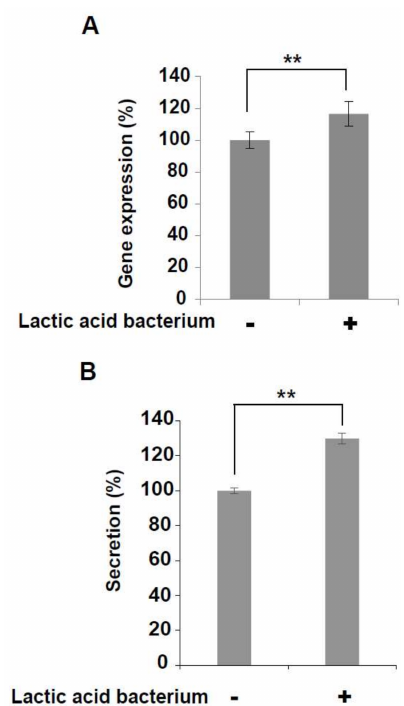
Figure 5. Increased expression and secretion levels of IFN- γ . ( A ) The expression level of IFN- γ mRNA was increased in KHYG-1 cells that had been treated with the six lactic acid bacteria mixture (3 × 10 4 cfu) for 4 h at 37 ◦ C in a 5% CO 2 incubator ( n = 3, ** p < 0.01). ( B ) The secretion level of IFN- γ mRNA was increased in the same, treated, KHYG-1 cells ( n = 6, ** p <